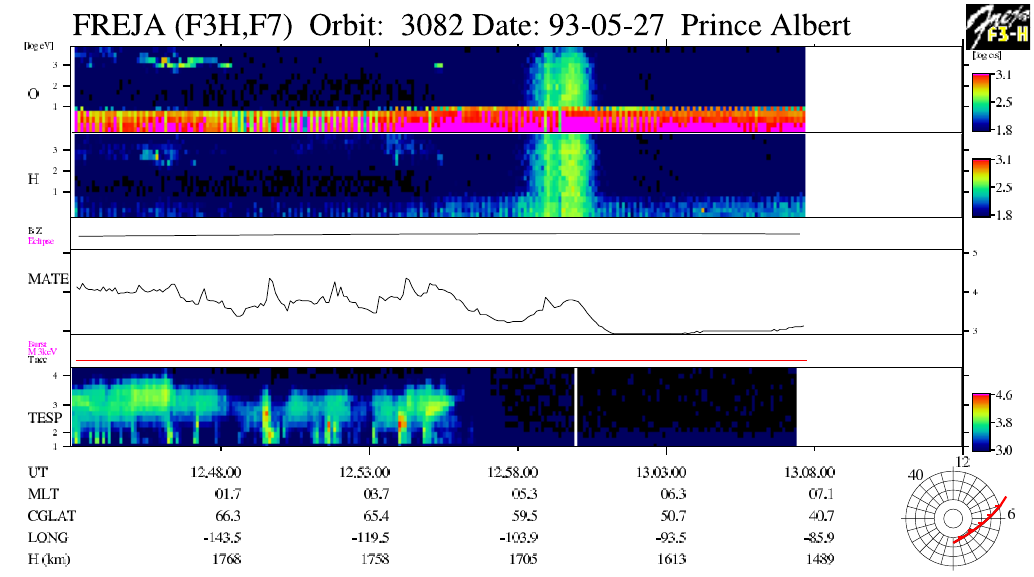
Fig. 6. A full-pass CSP for orbit 3082, covering MLT from midnight to 07:00 and CGLAT 67–42 ◦ . In the ion precipitation region there are mostly higher peak count rates of O + ions than of H + .